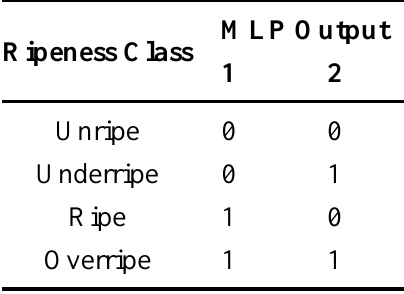
Table 4. Output coding representations for CE and CF